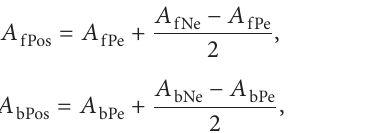
Figure6:Theheightandwidthofahumansilhouettewiththeimage profile of horizontal line drawn through the